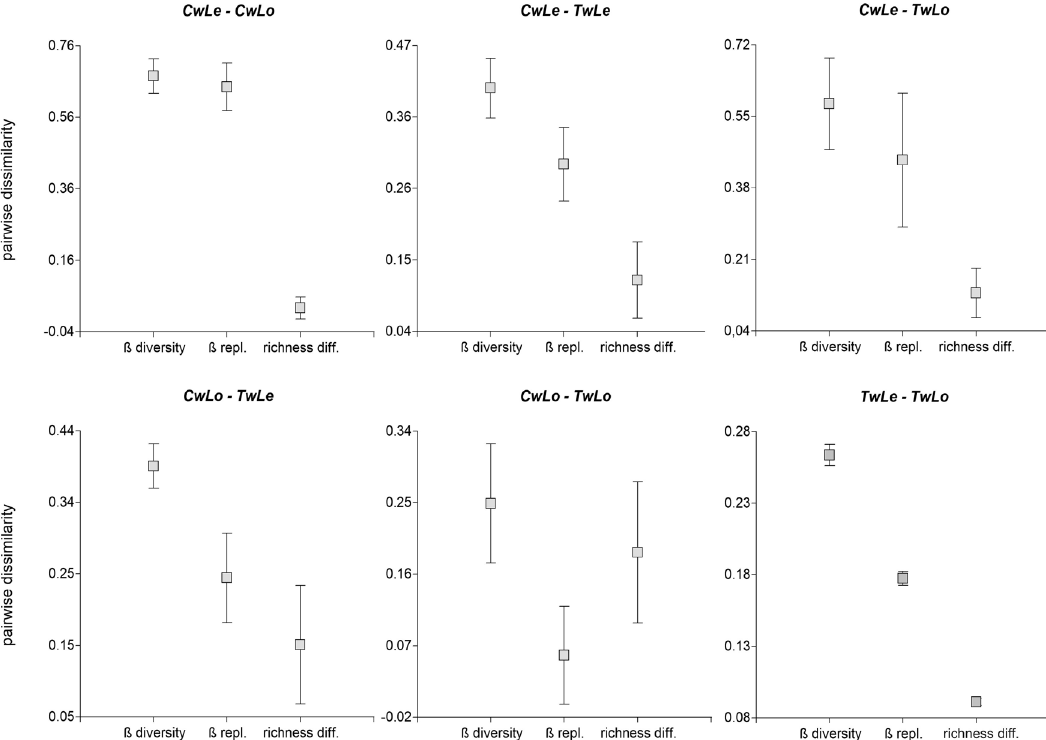
Figure 5. Means and standard deviation of beta diversity ( β diversity) and its components ( β repl.= replacement, β rich.= richness differences) calculated for different pairs of sampled sites of the Sauce Grande River (CwLe = clear water lentic conditions; CwLo = clear water lotic conditions; TwLe = turbid water lentic conditions; TwLo = turbid water lotic